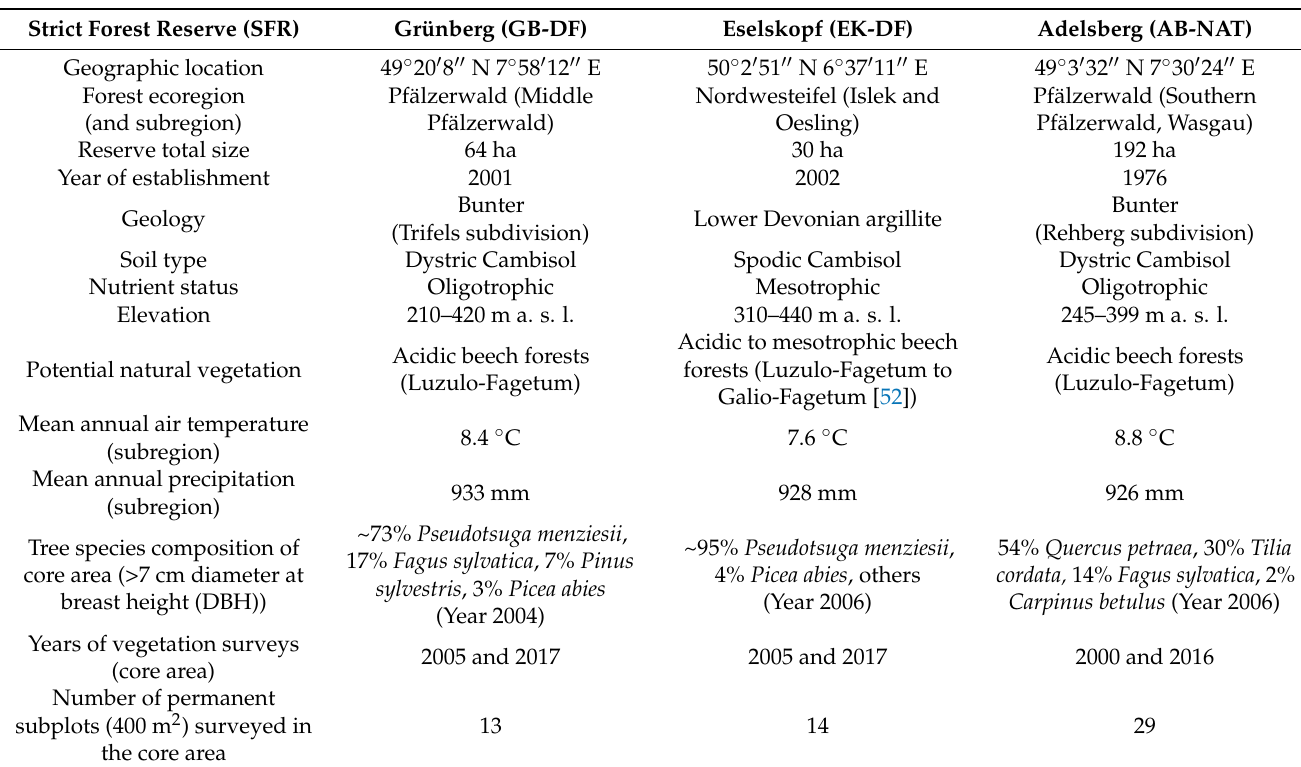
Table 1. Characteristics of the investigated strict forest reserves and its investigated core areas (following Gauer and Aldinger [51], BLE [53]). DF and NAT indicate the tree species dominance in the core area being Douglas fir or native tree